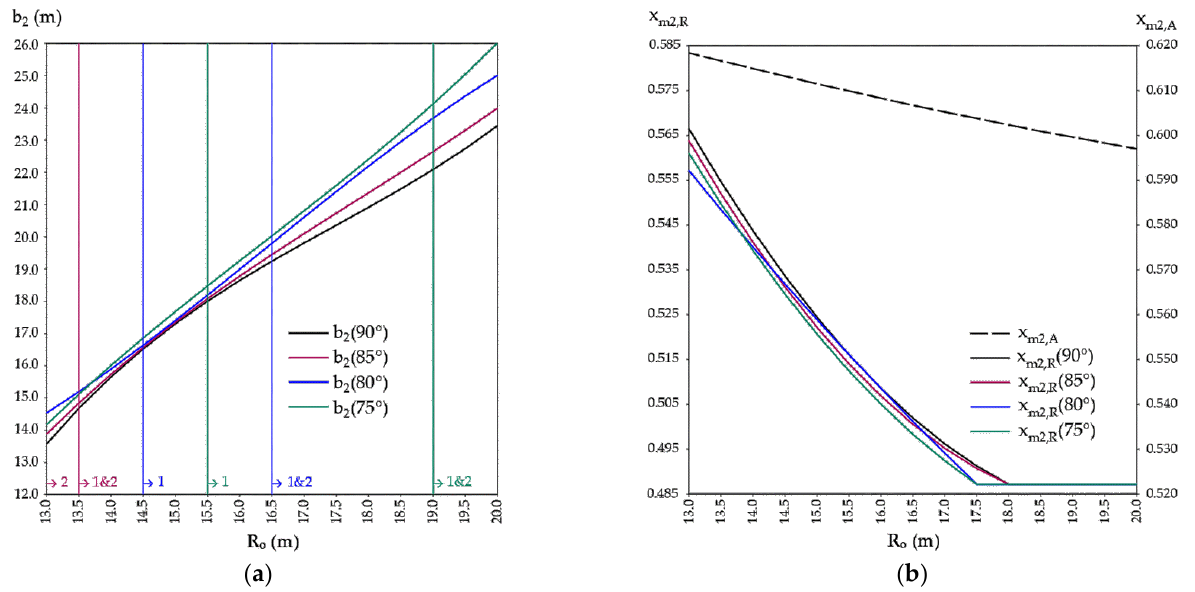
Figure 10. Investigated parameters at leg 2 as a function of R o for different δ, considering the application of design conditions 1 and 2: ( a ) geometric parameter b 2 ; ( b ) traffic parameter x m2 .